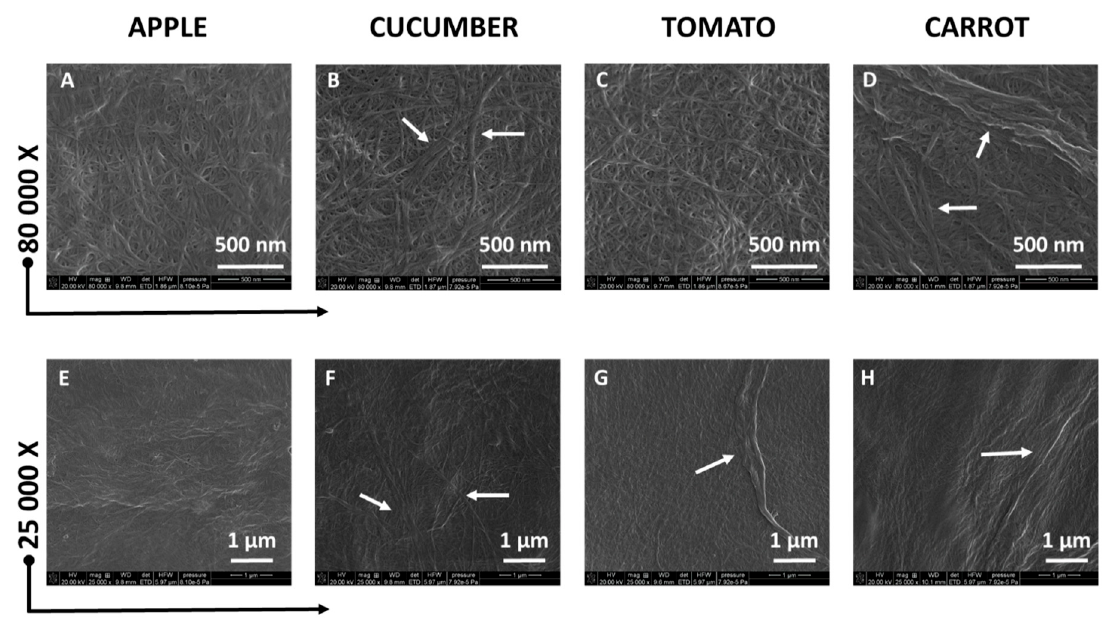
Figure 2. SEM micrographs presenting the cellulose isolated from apple ( A , E ), cucumber ( B , F ), tomato ( C , G ), and carrot ( D , H ) pomaces. White arrows mark the cellulose macrofibrils presence.